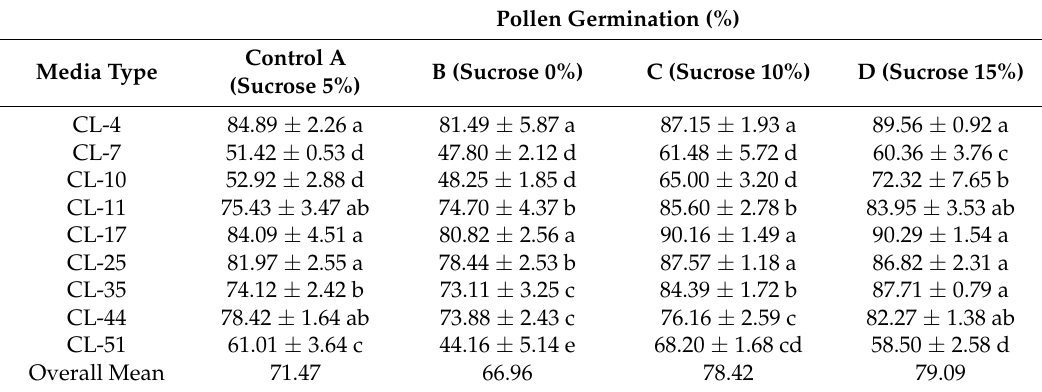
Table 2. Effects of sucrose concentrations on pollen